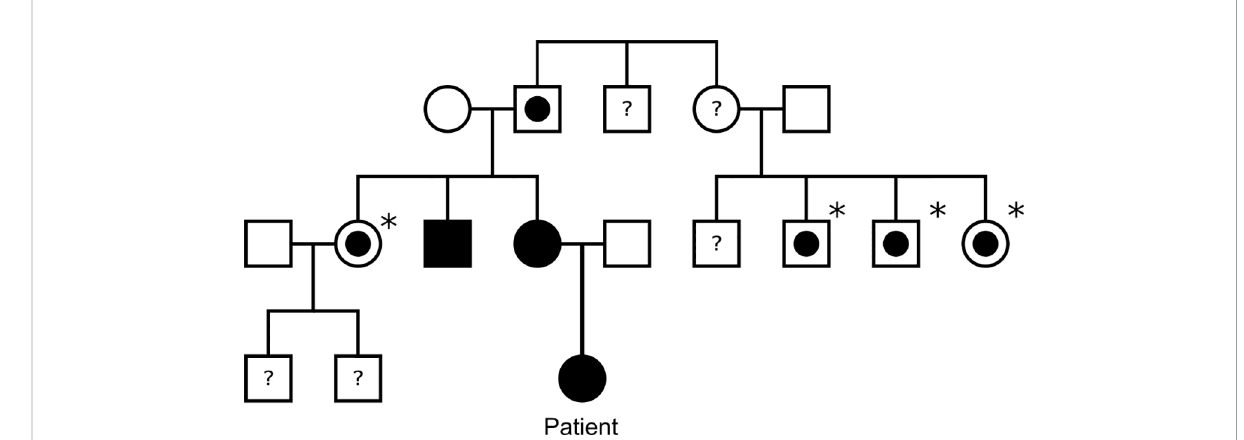
FIGURE 2 Family tree of the patient ’ s family. Black square/circle: male/female with paraganglioma and con fi rmed SDHB mutation. White square/circle with circle within: male/female with con fi rmed SDHB mutation, but no known paraganglioma. Asterisk: indicates patient has not undergone tumour screening. White square/circle: male/female with no known SDHB mutation or paraganglioma. Question mark: indicates patient has not undergone genetic testing for SDHB